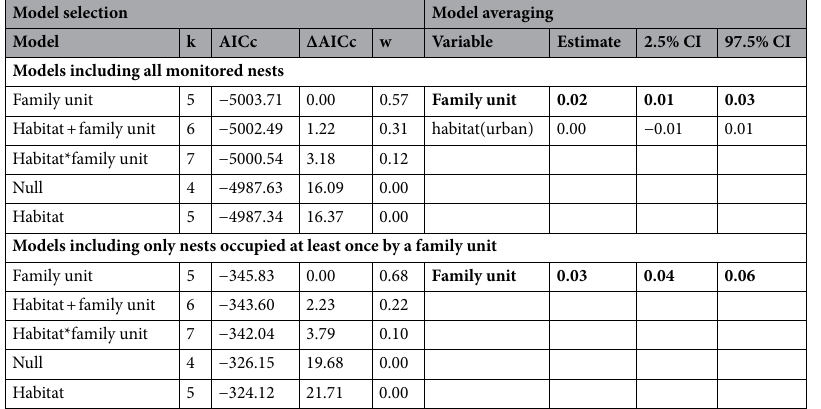
Table 4. Models obtained to assess the effects of family units on the body condition of chicks raised by urban and rural burrowing owls Athene cunicularia . Estimates and 95% confidence intervals (2.5% and 97.5%) were assessed after model averaging. All models were run including “year” and “nest” as random terms. k: number of parameters, AICc: Akaike Information Criterion corrected for small sample sizes, ΔAICc: the difference between the AICc of model i and that of the best model (i.e. the model with the lowest AICc), w: Akaike weights. The fit of the models including all variables used in model averaging can be checked in Fig. S6. In bold, variables receiving strong support (i.e., the 95% confidence interval did not overlap with